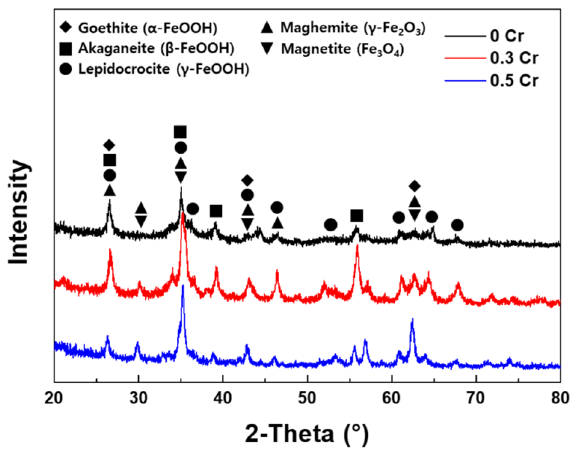
Figure 9. XRD analysis of the specimen surfaces after 20 cycles of CCT.